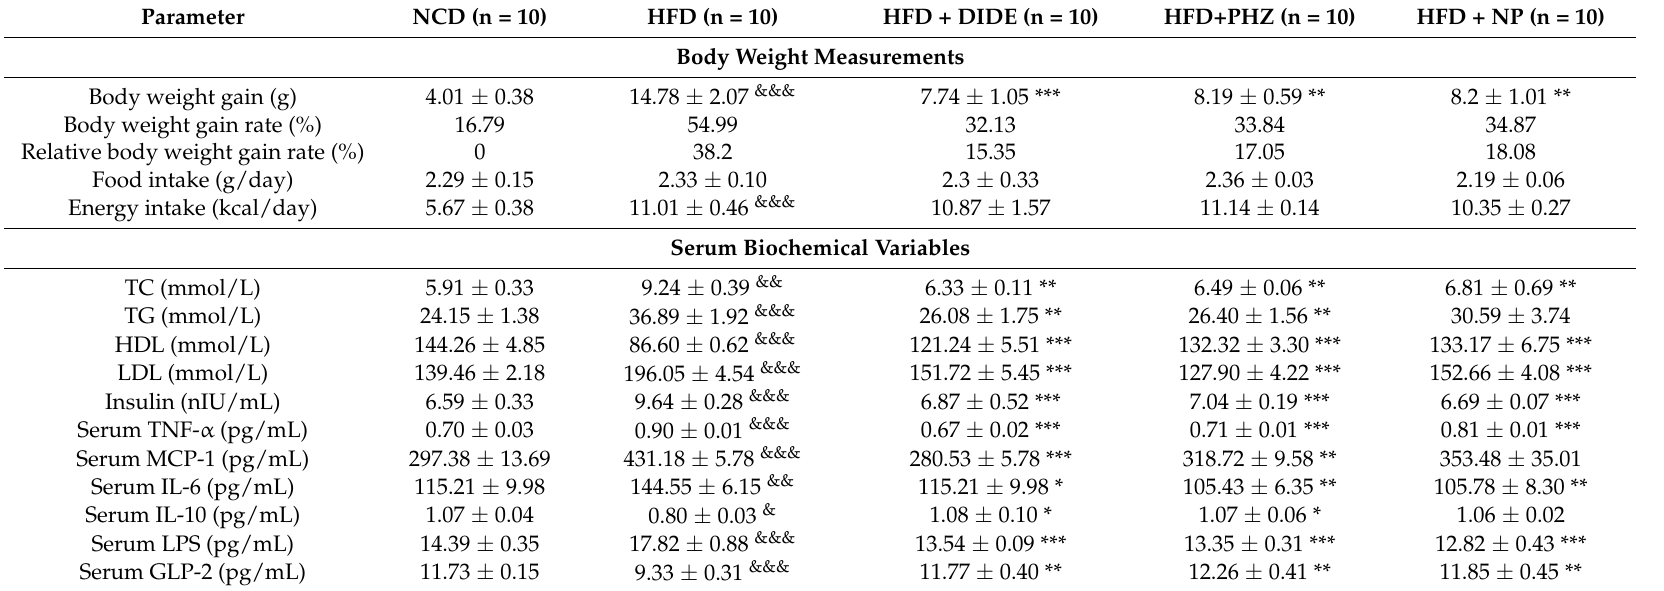
Table 2. Effects of DIDE, PHZ, and NP on metabolic parameters in different groups at the end of 13-week HFD